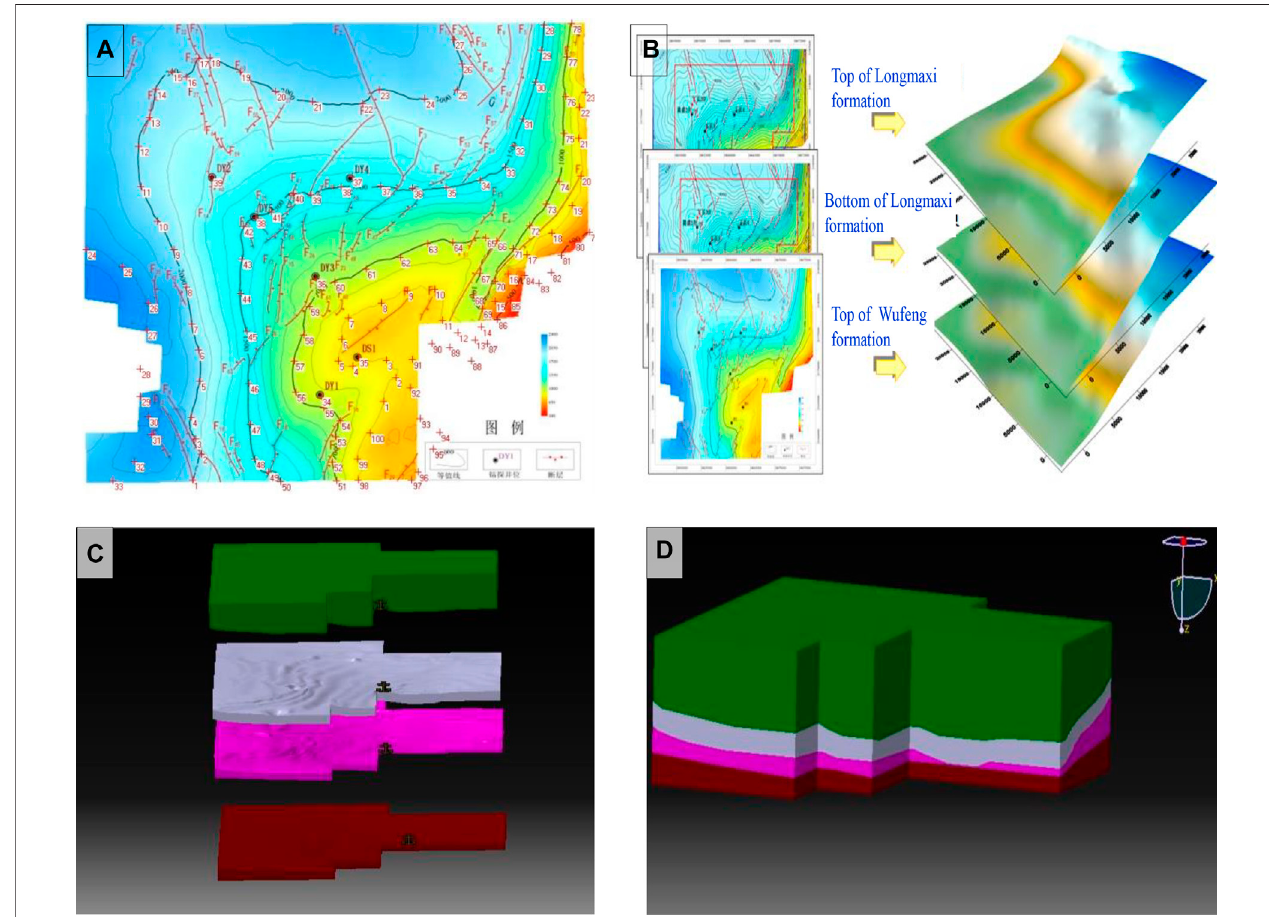
FIGURE 10 | Modeling process of numerical simulation. (A) Construction information extraction point distribution map. (B) Fitting surface of each layer interface. (C) Development map of rock geological body. (D) 3D geological model of Longmaxi formation shale in Dingshan area.